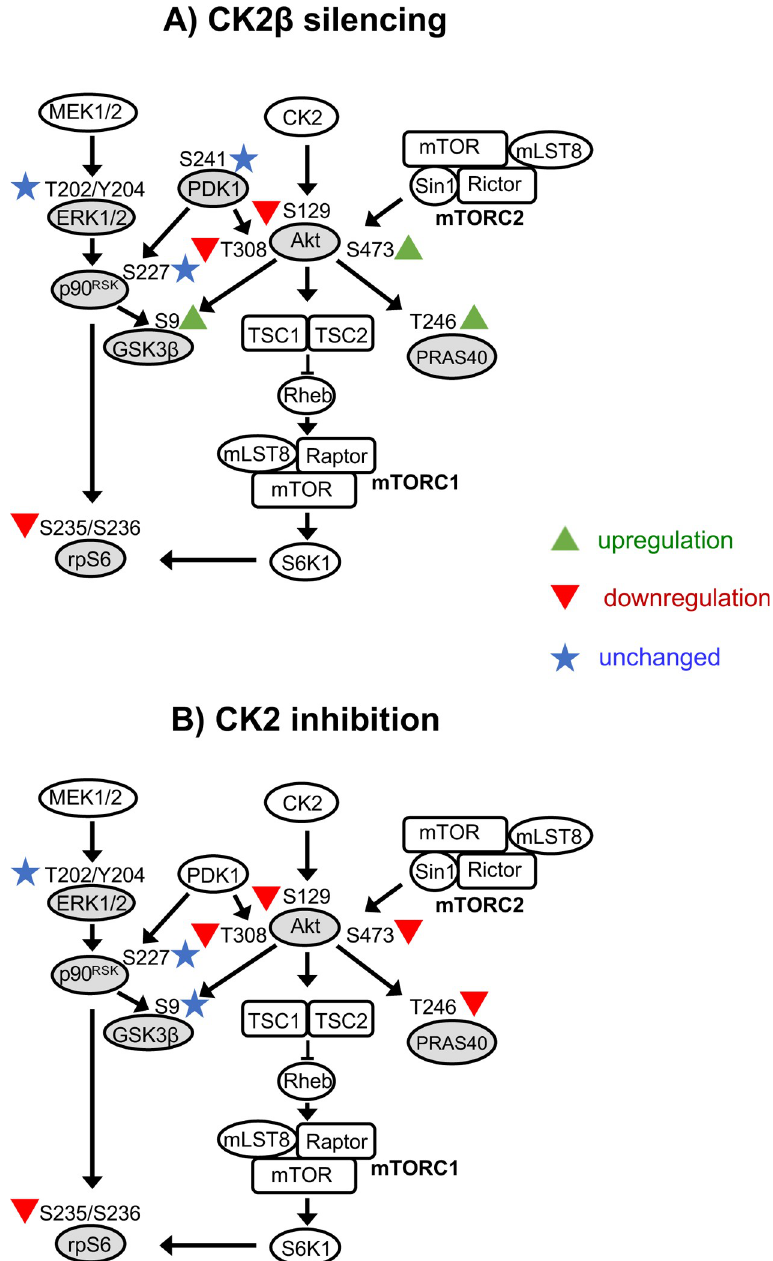
Fig 4. Diagram showing some potential interactions of CK2 with proteins involved in the PI3K/Akt/mTOR and ERK1/2 pathways. The components whose specific phosphorylation has been checked in this work are indicated in grey. The effects of CK2 β silencing (A) or CK2 inhibition by CX-4945 (B) in HK-2 cells are highlighted by colours (upregulation in green, downregulation in red, unchanged in blue). The effect of CX-4945 on Akt pS129 is inferred from previous work of our and other laboratories (e.g.